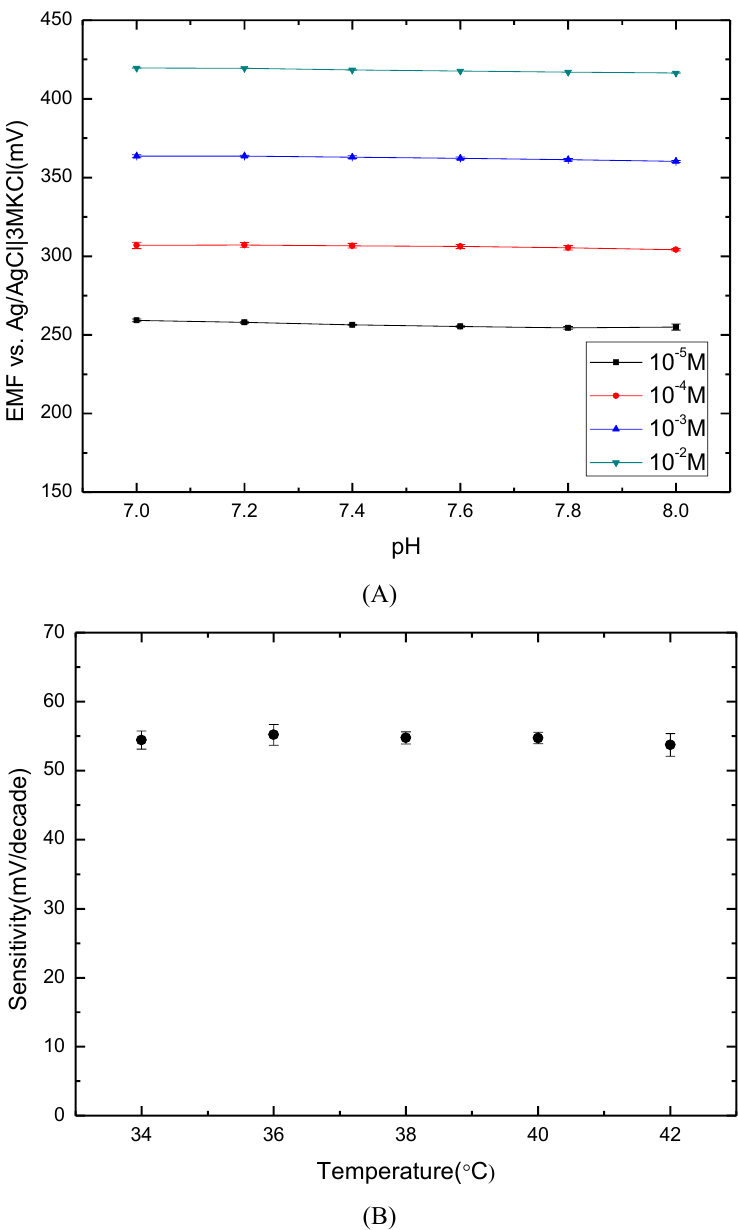
Figure 4. ( A ) Potentiometric response (10 − 5 –10 − 2 M of ChCl solutions) within a pH range of 7.0–8.0 in the background of acetate buffers; and ( B ) the effect of temperature on the sensitivities of the Ch ISE within the range of 34–42 ◦